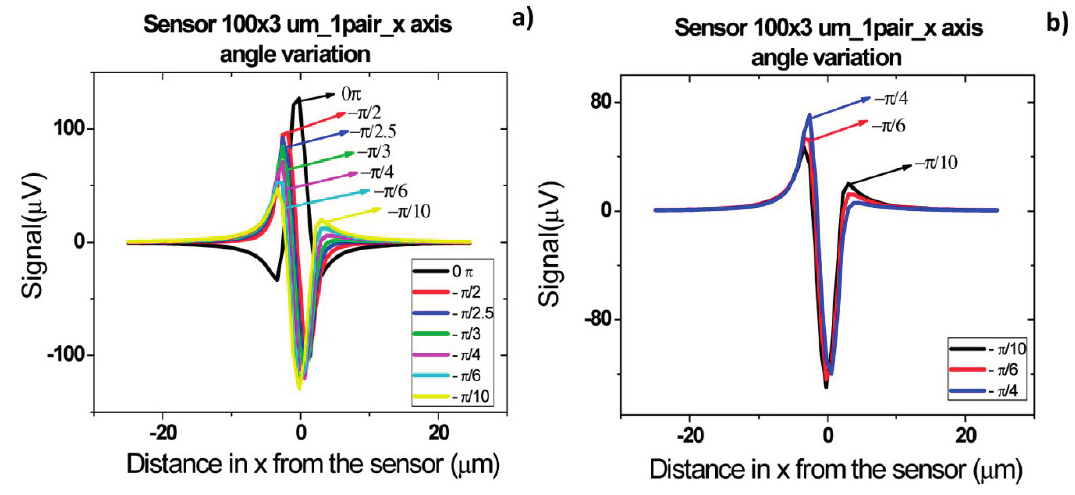
Figure 21. Signal simulation for detection of a Streptococcus agalactiae cell using a 100 × 3 μ m 2 sensor ( a ) oriented along x axis considering different magnetic moment angles relative to the x axis; ( b ) Selection of simulated